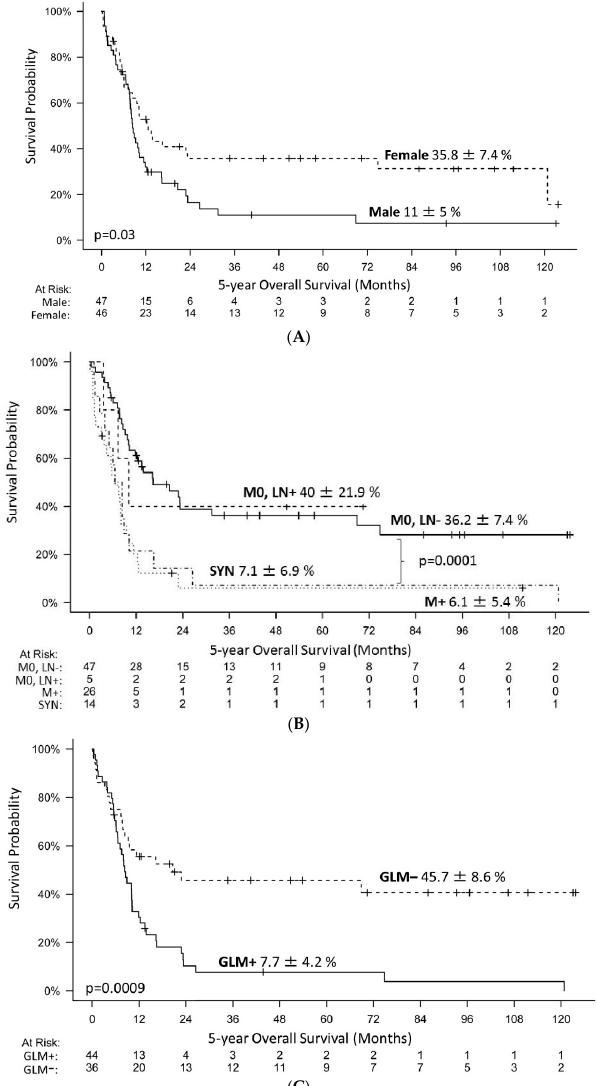
Figure 2. The 5-year overall survival (OS) of 93 consecutive patients treated according to the EU- RHAB consensus therapy. ( A ) The 5-year OS was 35.8 ± 7.4 % for female and 11 ± 5% for male patients. ( B ) The 5-year OS was 36.2 ± 7.4% for patients with localised disease without loco-regional lymph node involvement (M0, LN − ), 40 ± 21.9 % for patients with loco-regional lymph node involvement (M0, LN+), 6.1 ± 5.4% for patients with metastasis (M+) at diagnosis and 7.1 ± 6.9% for patients with synchronous tumors (SYN). ( C ) The 5-year OS was 7.7 ± 4.2% for patients diagnosed with germline mutation (GLM+) and 45.7 ± 8.6% for those without (GLM −